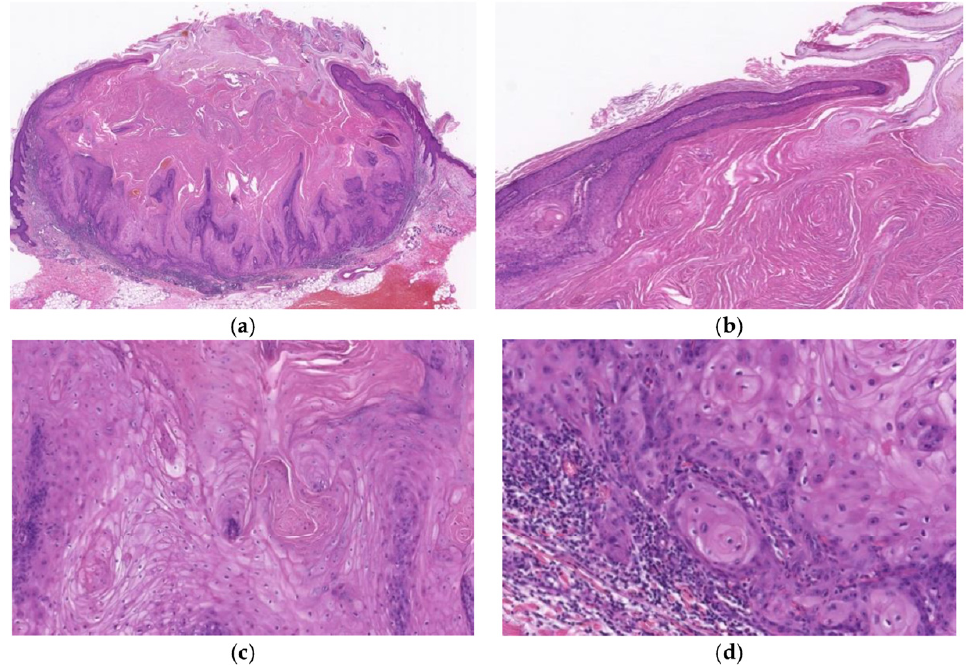
Figure 3. Histopathological findings of KA at the well-developed stage. Gross findings of the lesion include crateriform and exo-endophytic architecture with a central keratinous plug ( a ). Overhanging epithelial lips with a normal overlying epidermis are observed ( b ). Characteristic proliferation of large pale pink cells with a glassy appearance showing compact keratinization is observed in most parts of the lesion ( c ). The deeper areas of the lesion are slightly poorly demarcated from the surrounding stroma and exhibit slightly invasive growth ( d